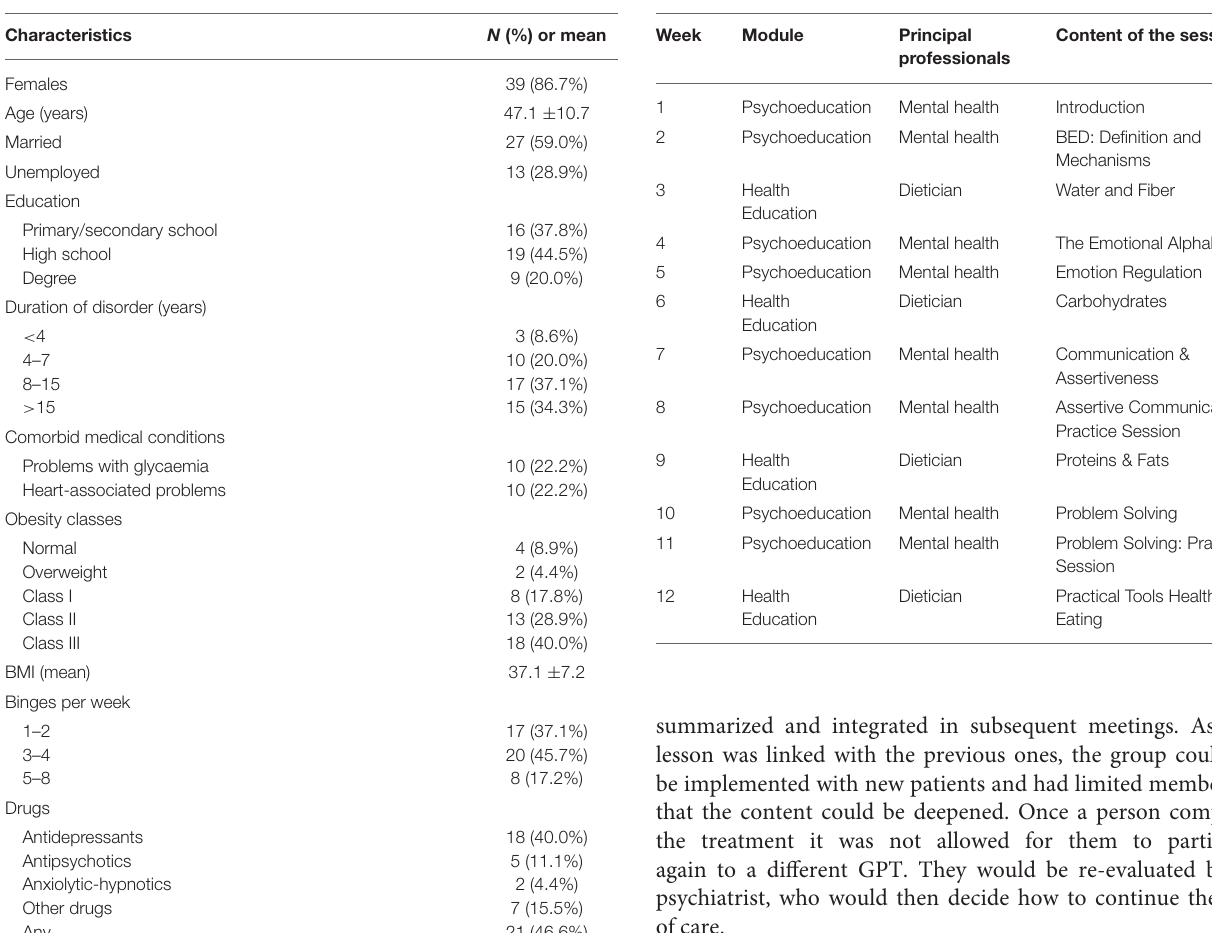
TABLE 1 | Characteristics of the sample. TABLE 2 | Group program